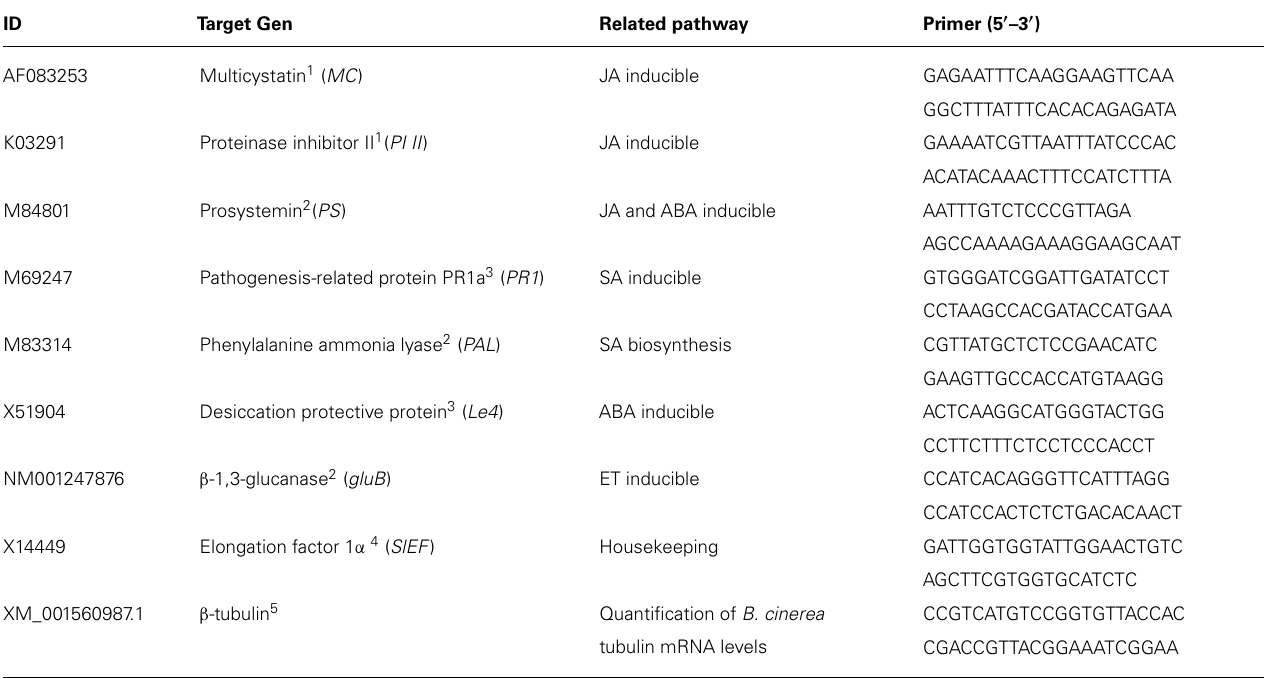
Table 1 | Primer sequences used in the gene expression analysis.The genes monitored are used as markers for the pathways indicated. Jasmonate (JA), salicylic acid (SA), abscisic acid (ABA), and ethylene (ET). ID Target